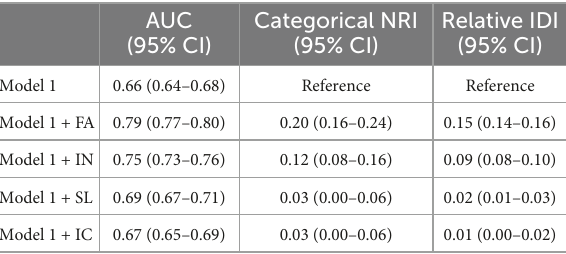
TABLE 7 Comparison of the performance of diagnostic